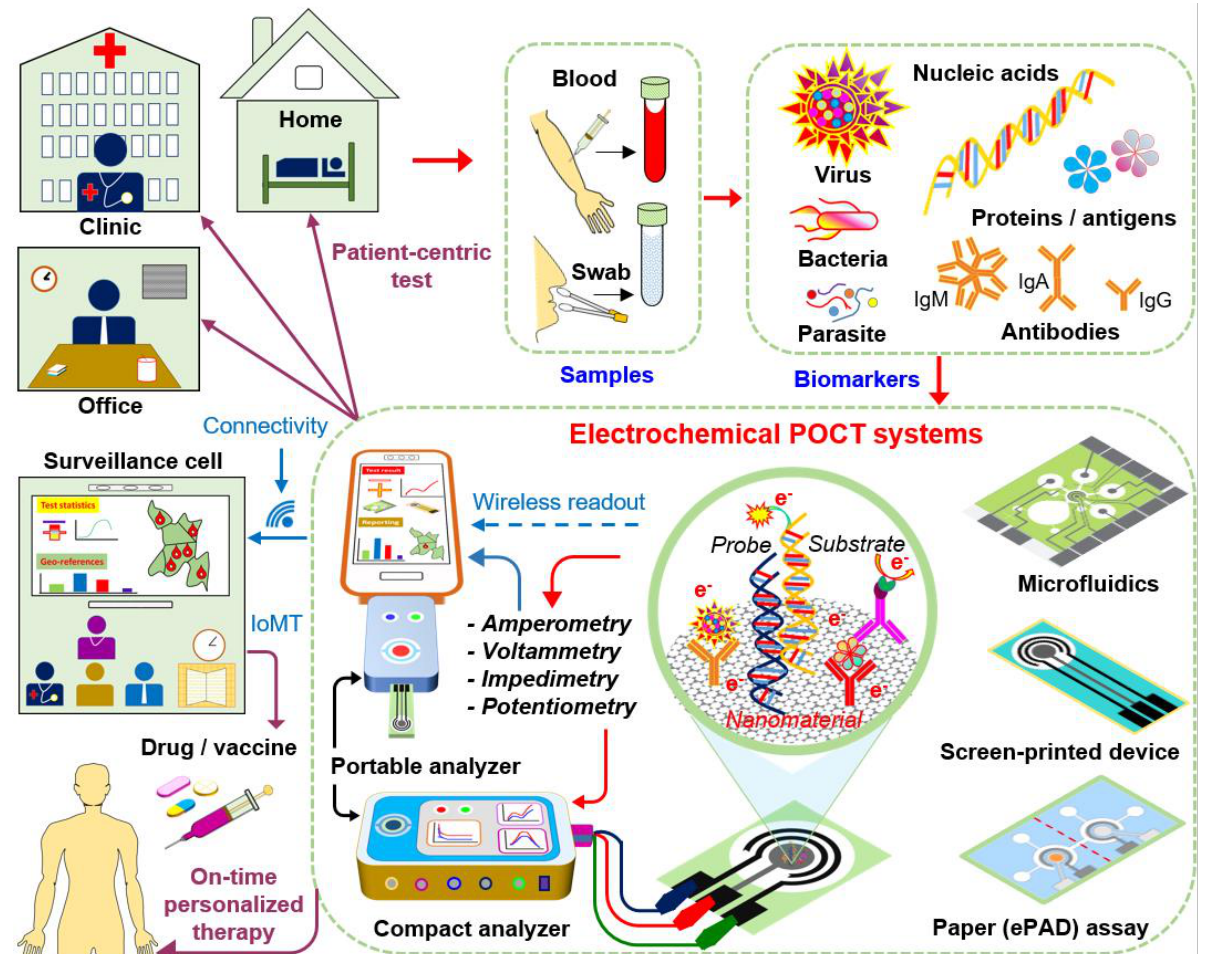
Figure 1. Schematic of electrochemical point-of-care testing (POCT) systems. POCT platforms (for example, compact/portable diagnostic analyzers, microfluidics, lab-on-chips/screen-printed devices, and paper-based assays) facilitate patient-centric (or decentralized) diagnosis of infectious diseases by detecting a variety of biomarkers (e.g., virus particles, bacteria, nucleic acids, proteins/antigens, and antibodies) at homes, offices, or nearby clinics without trained staff so that the on-time personalized therapy can be approached. The connection between POCT systems and surveillance cells enables epidemiological reporting during the pandemic epoch.